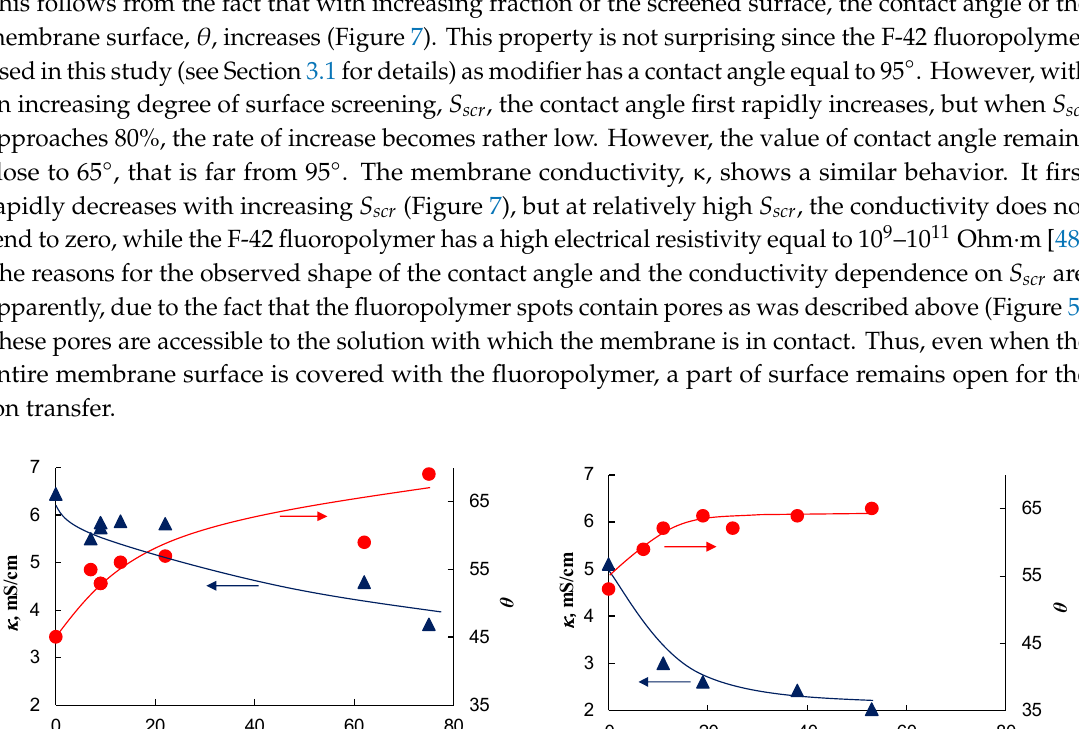
Figure 6. Image of the modified surface with reference points ( a ) and surface profile ( b ) of the AMX-Sb 2 membrane. Points A and D limit the considered segment of the membrane surface; B and C refer to the boundaries of the fluoropolymer spot.